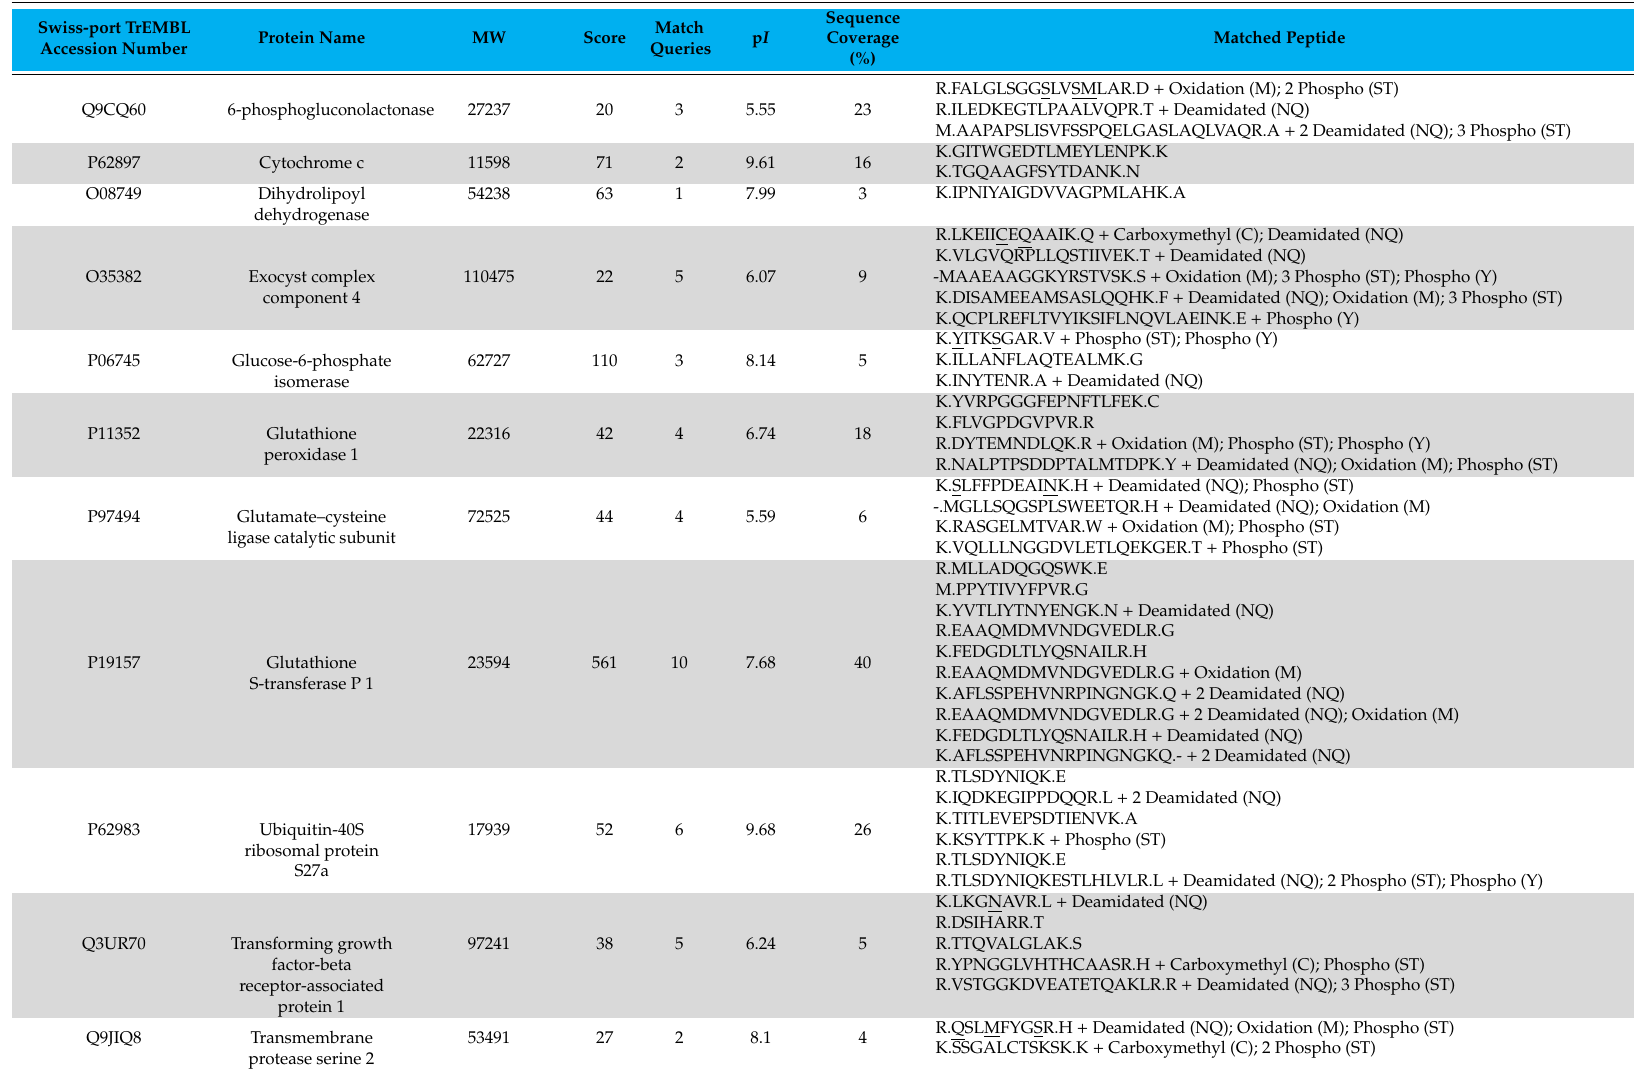
Table 3. Summary of proteins corresponding to HBV